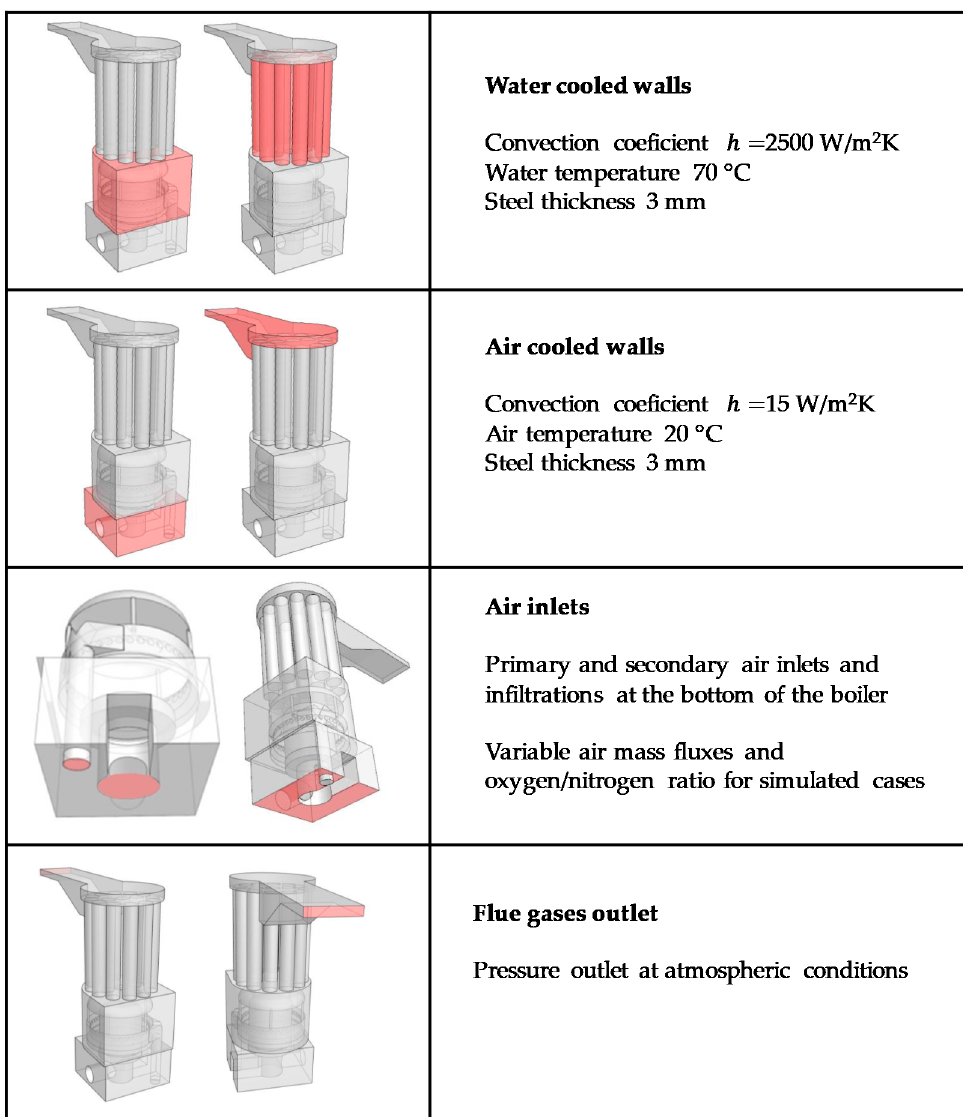
Figure 4. Main boundary conditions of the boiler model.